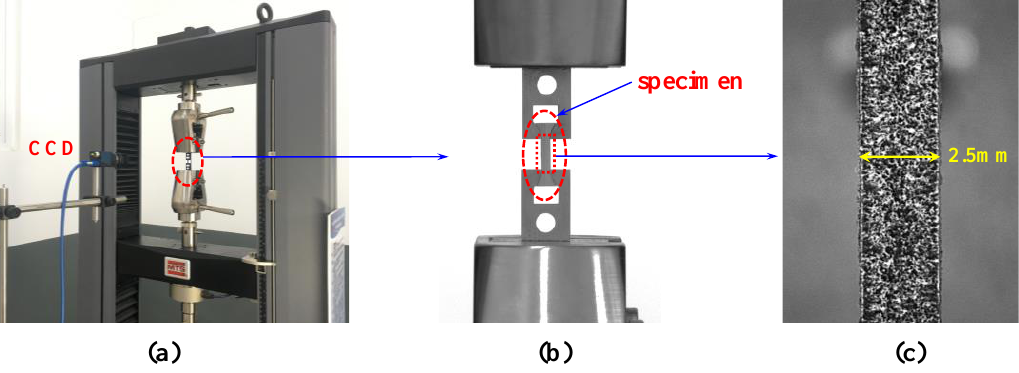
Figure 3. The experimental setup and speckle pattern on the surface of specimen: ( a ) the full experimental setup; ( b ) the chuck and specimen; ( c ) speckle pattern on the surface of specimen.